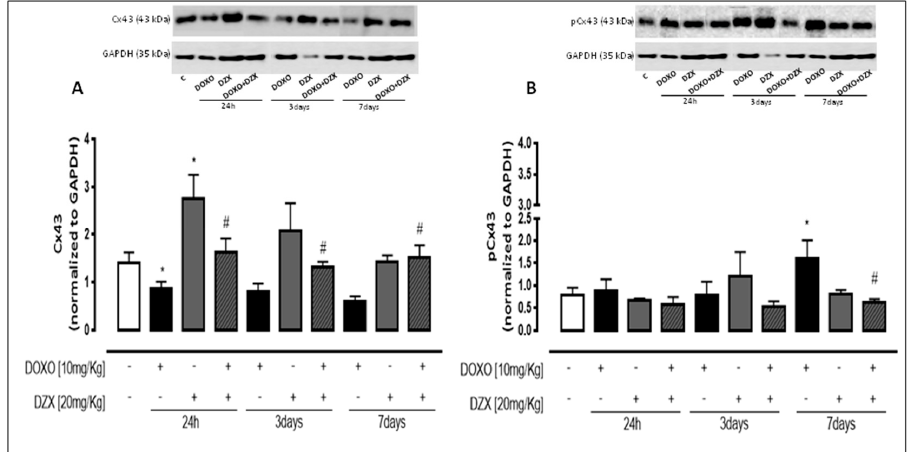
Figure 2. Effect of DOXO or DZX or combined DZX+DOXO treatment on Cx43 ( A ) and pCx43 ( B ) amount. Mice received a single administration (1th group), two administrations (2nd group), or three administrations (3rd group) of DOXO (10 mg/kg; i.p.) or DZX (20 mg/kg; i.p.) or combined DZX+DOXO treatment and Cx43 and pCx43 amount was detected by Western blot analysis of tissue homogenates from mice; GAPDH amount was used as loading control. Values were expressed as mean ± S.E.M. from at least three independent experiments each performed in duplicate. Data were analyzed by Student’s t -test. * p < 0.05 vs. control; # p < 0.05 DZX+DOXO vs. DOXO.